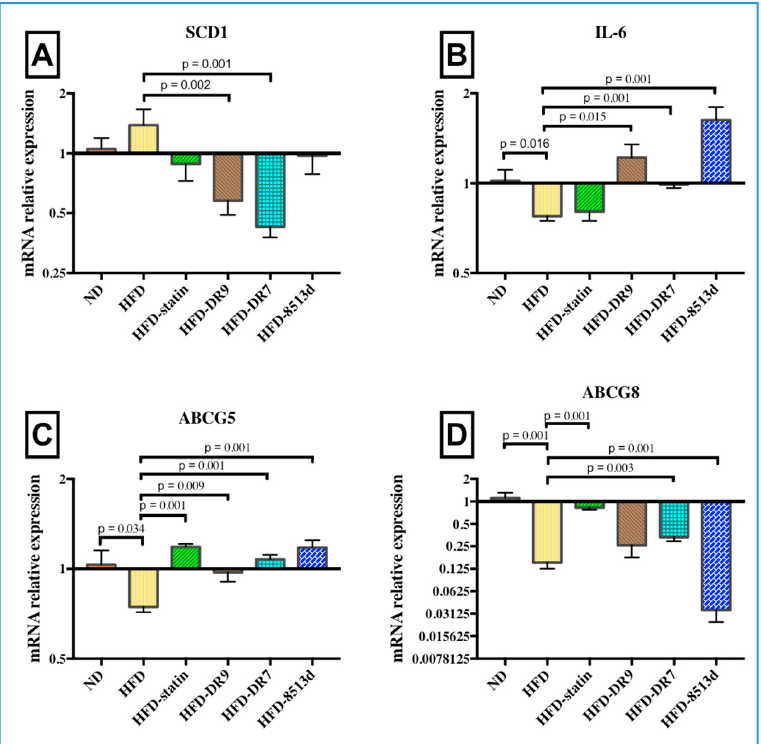
Figure 6. Relative gene expression of ( A ) SCD1 , ( B ) IL-6 , ( C ) ABCG5 , and ( D ) ABCG8 in liver of D-galactose-induced aging rats (600 mg / kg / day) after 12 weeks of treatment. ND (normal diet), HFD (high-fat diet), HFD-statin (high-fat diet, receiving lovastatin 2 mg / kg / day), HFD-DR9 (high-fat diet, receiving L. fermentum DR9 (10 10 CFU / day), HFD-DR7 (high-fat diet, receiving L. plantarum DR7 (10 10 CFU / day), HFD-8513d (high-fat diet, receiving L. reuteri 8513d (10 10 CFU / day). Results are expressed as mean; error bars (SEM); n = 6. Statistical analysis was performed using independent t -tests.